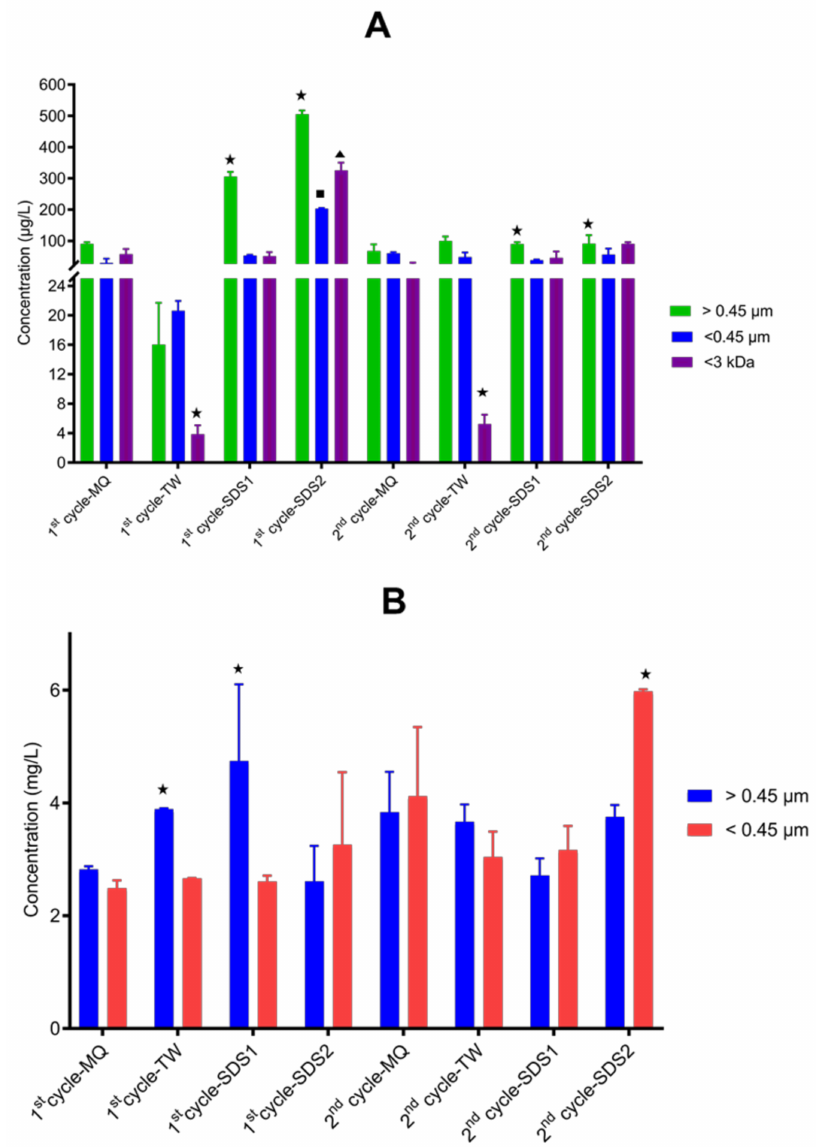
Figure 7. Total amounts of Ag ( A ) and Ti ( B ) released from SK1 in Milli-Q water (MQ), tap water (TW), sodium dodecyl sulfate 1 (SDS1), and sodium dodecyl sulfate (SDS2) in two wash cycles. The symbol ( (cid:70) (cid:4) ) on top of error bars denote statistical difference ( p < 0.05) between the released Ag and Ti fractions per wash